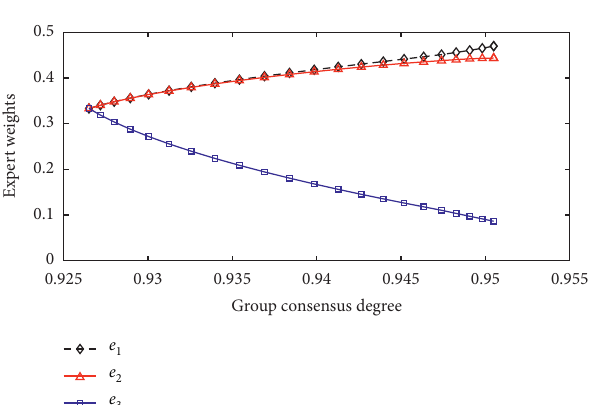
Figure 4: Group-consensus levels with the updating of weights of experts by Algorithm 3.